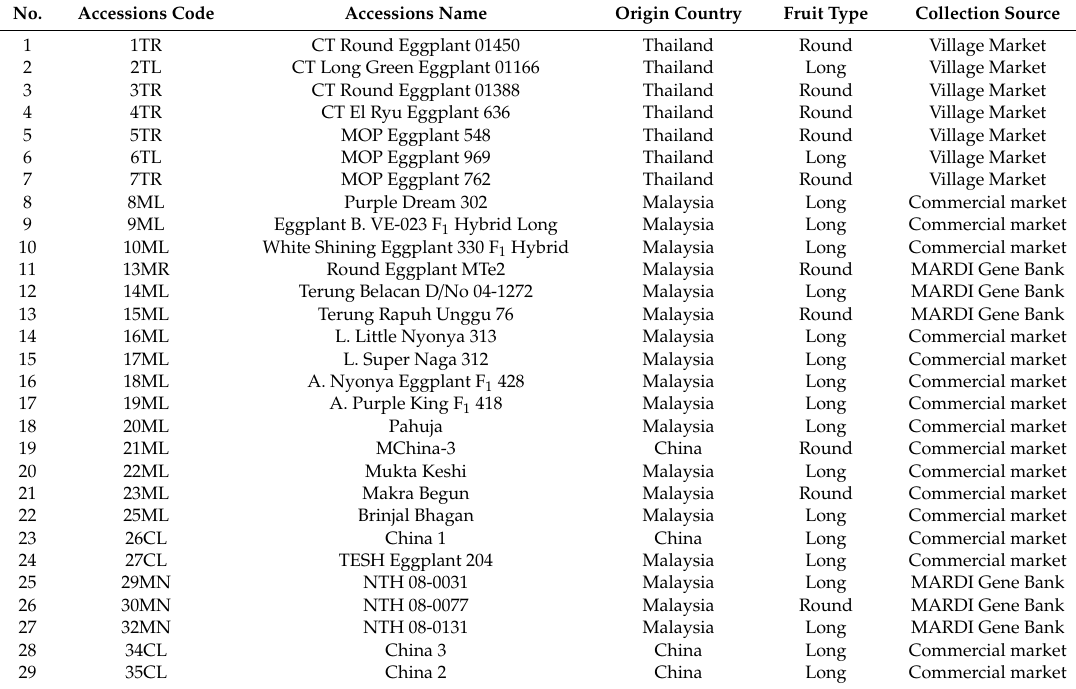
Table 1. List of 29 eggplants